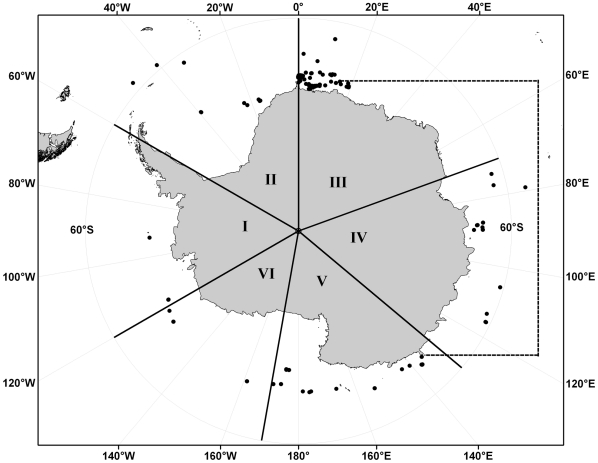
Locations of biopsy samples collected from Antarctic blue whales during IDCR/SOWER cruises from 1990 and 2009.Solid lines demarcate IWC management Areas (I–VI). Dashed line depicts inferred movement of an Antarctic blue whale between Areas over an elapsed time of 4 years based on genotyped recapture locations (Z-51452).